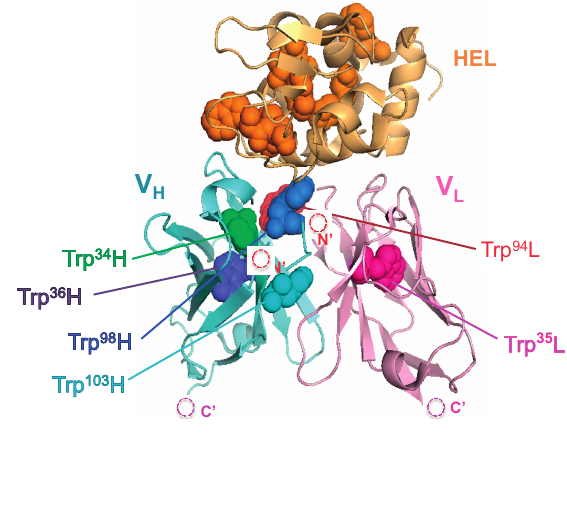
Figure 1. Schematic structure of HyHEL-10 Fv/HEL complex (based on PDB 2dqj). The structure of V , V , and HEL are shown in blue, pink, and orange, respectively. H L The Trp residues are shown as a space-filling model, with their name for those in the